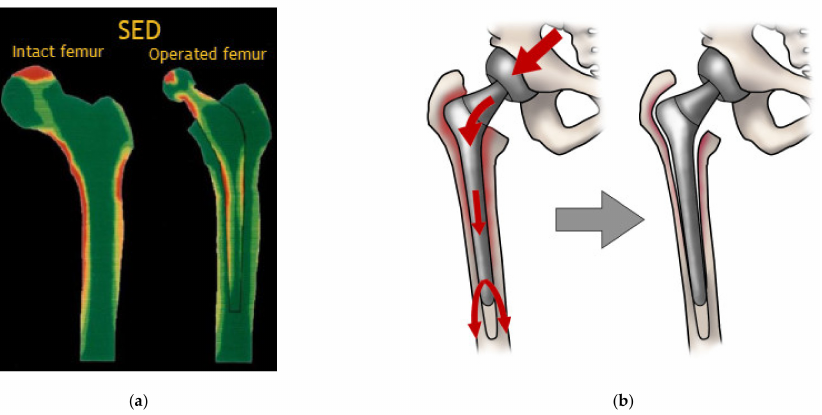
Figure 2. Elastic modulus of bone, PEEK, and metals usually used in implants (a) [22]; (b) [23]; (c) [24]; (d) [25].